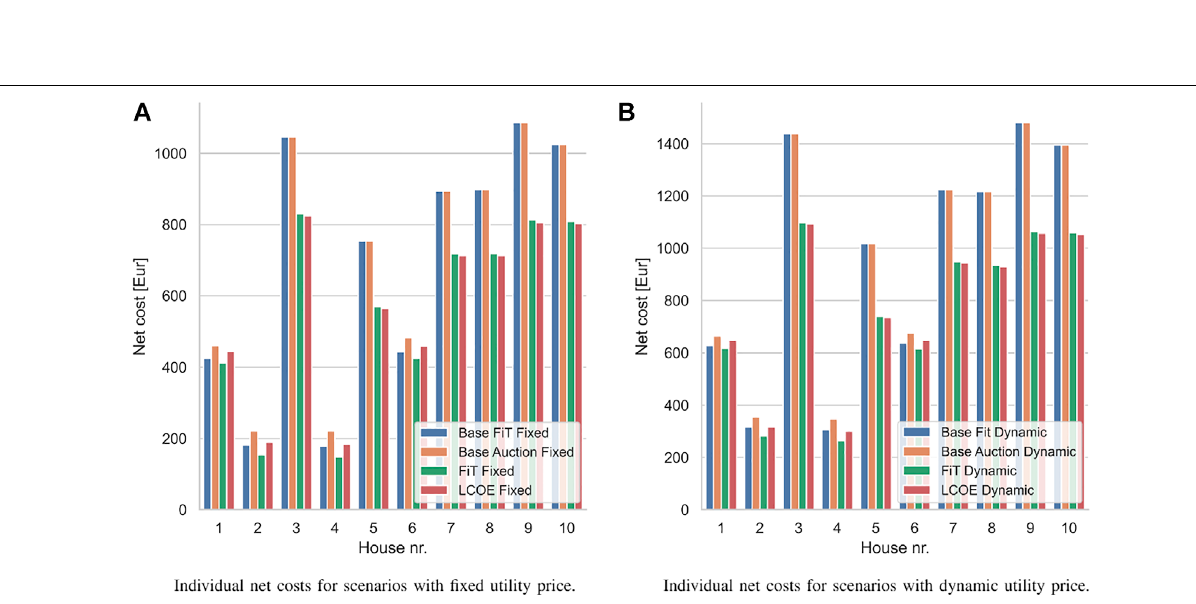
FIGURE 10 | Net costs of all market participants for (A) scenarios with fixed utility price and (B) scenario with dynamic utility price.